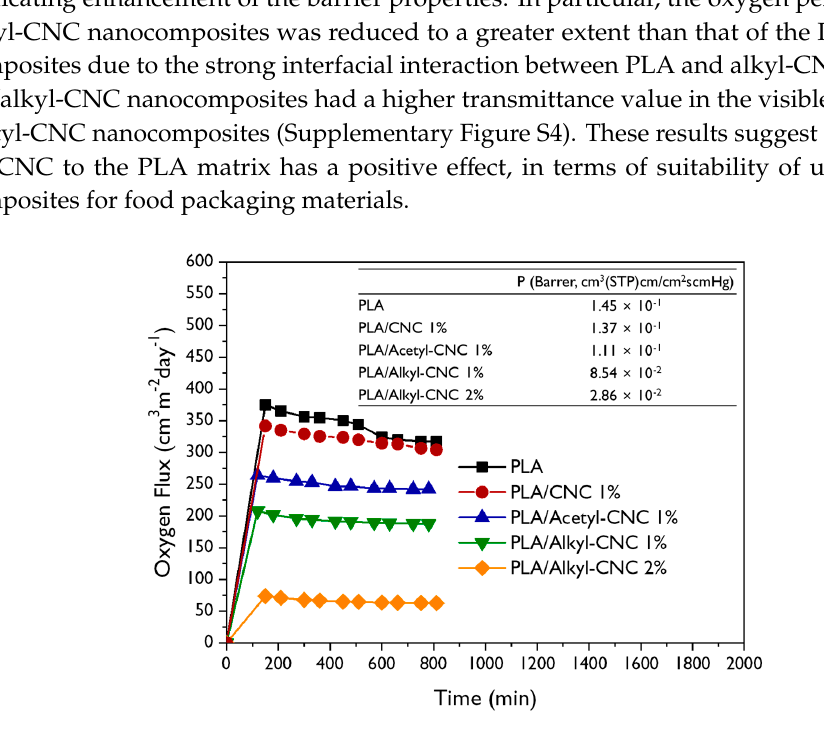
Figure 8. Oxygen flux rate and oxygen permeability coefficient of the neat PLA and PLA Figure8. Oxygenfluxrateandoxygenpermeabilitycoe ffi nanocomposites.